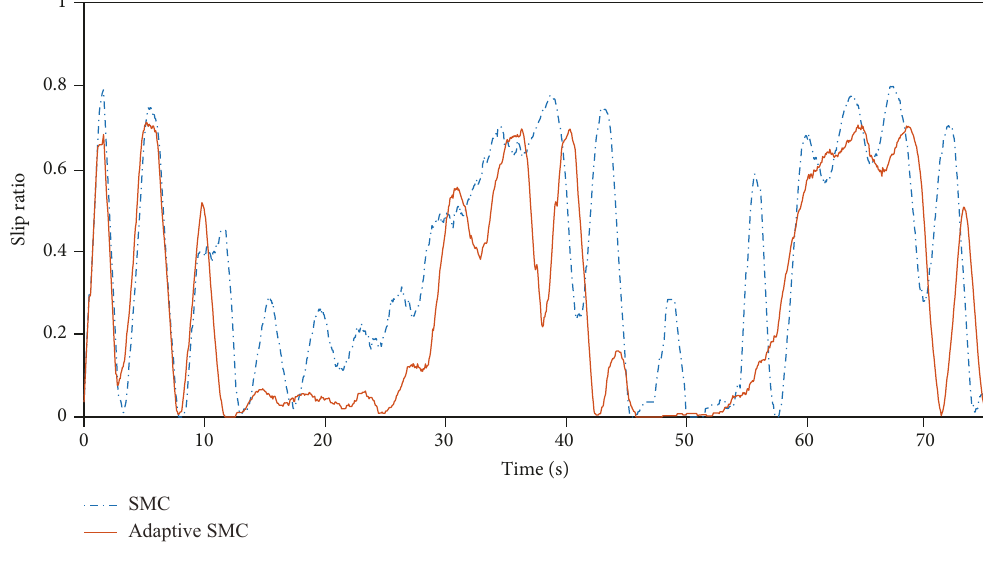
Figure 19: The slip rate changes of the WMR with SMCs. Table 3: The comparison of accumulated absolute error ratios with di ff erent control methods for tracking a cosine trajectory. X -direction Y -direction Steering angle Open-loop, without slip compensation 13.082% Open-loop, with slip compensation Traditional SMC with slip compensation Adaptive SMC with slip